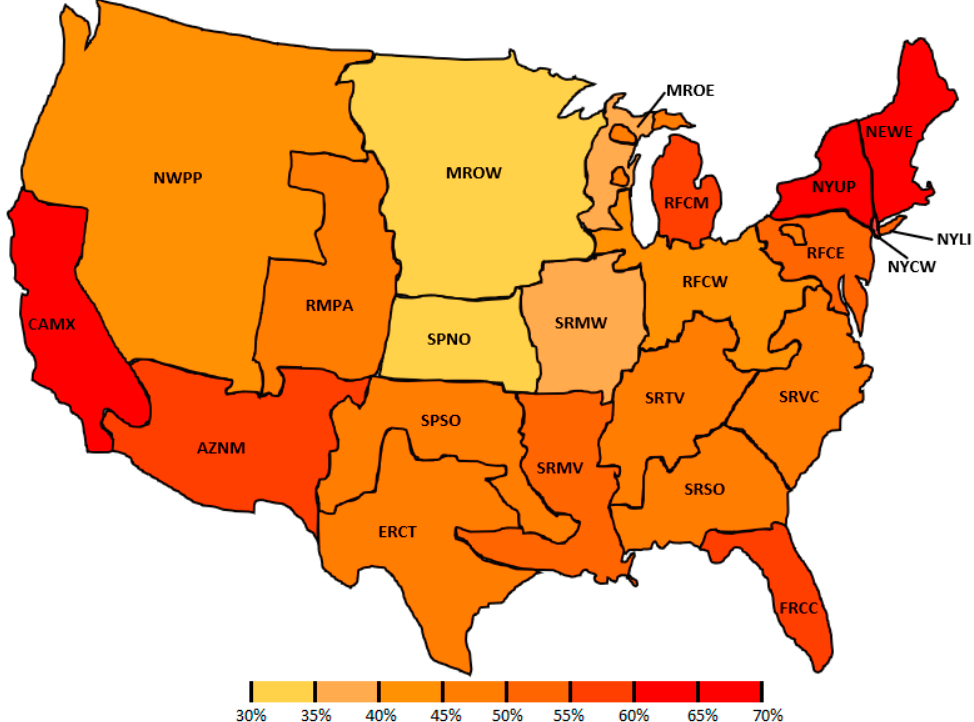
Figure 3. Percent reduction in CO 2 emissions from 20 MW of Reg A frequency regulation operating 24 h a day for a year using the BESS instead of the natural gas plant, with compensated generation assumptions.